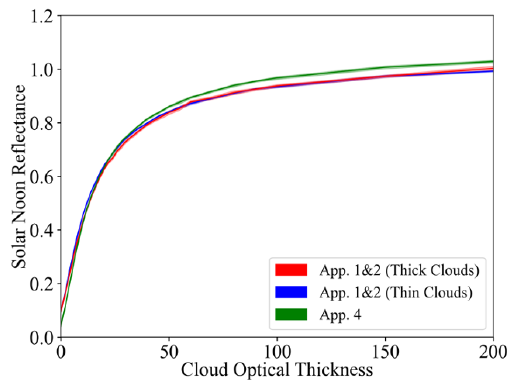
Figure C2. The IPA reflectance-to-COT mappings used for Apps. 1 and 2 (red and blue) and App. 4 (green). The reflectance is normal- ized by the cosine of solar zenith angle (referred to as solar noon reflectance). The uncertainties associated with photon statistics are indicated by the shaded